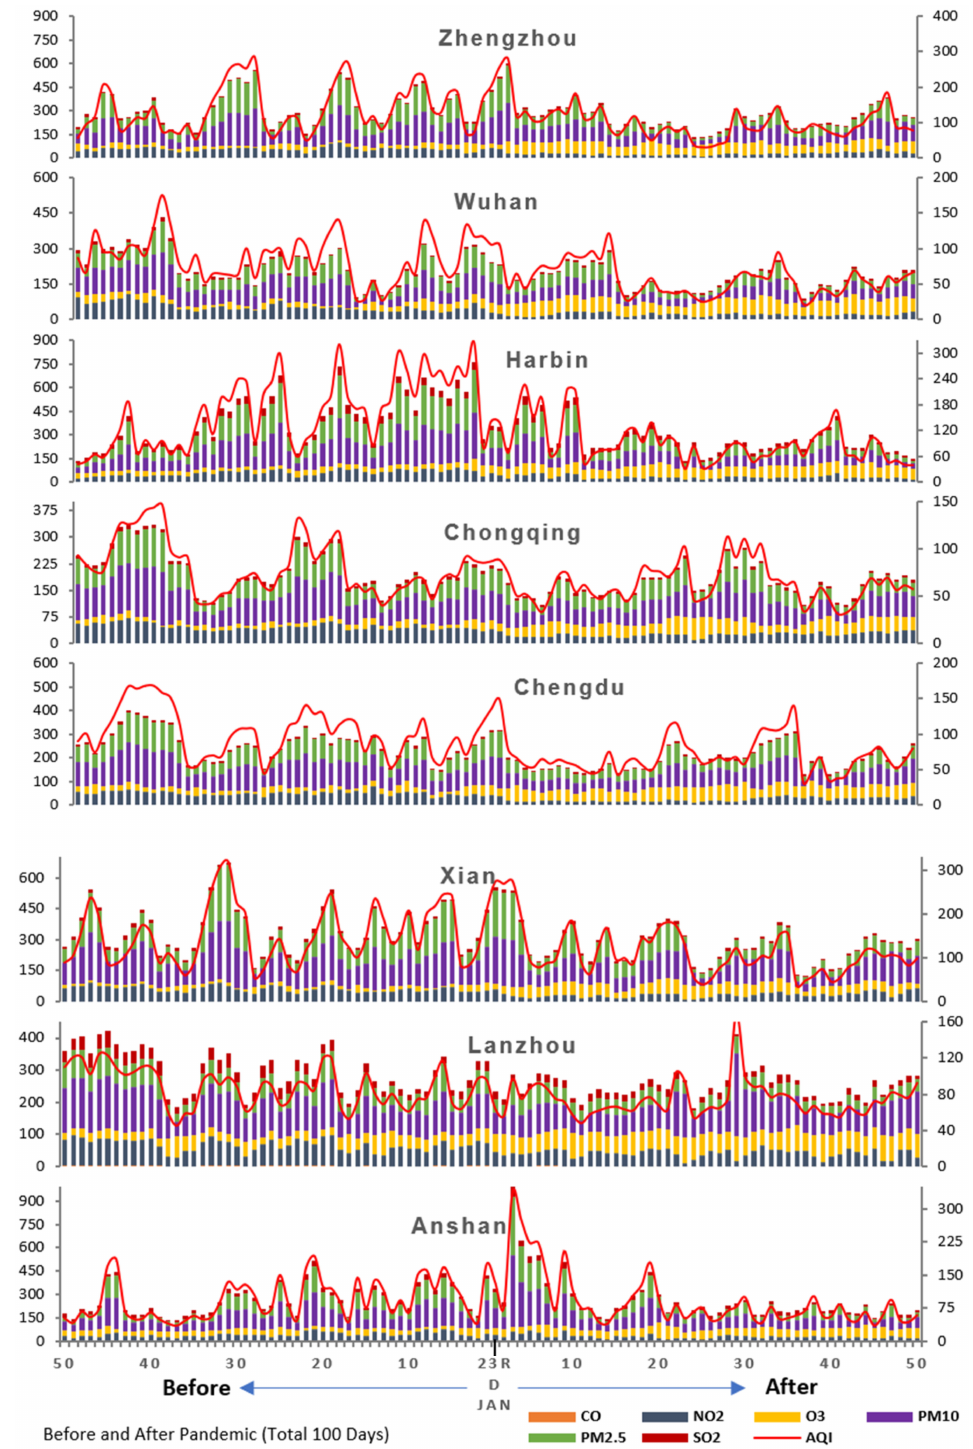
Figure 9. The daily average concentration of air pollutants in 14 cities of China. The 100 days (50 days before lockdown and 50 days after lockdown. NO 2 , O 3 , PM 10 , PM 2.5 , SO 2 ( µ g/m 3 ), and CO (mg/m 3 ): primary vertical (left) and AQI shown in secondary vertical (right). Source: Ministry